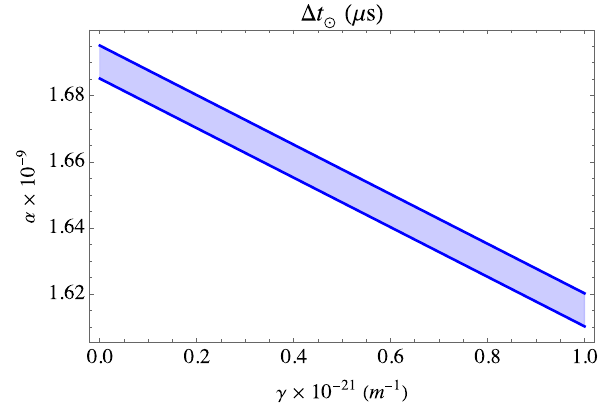
Fig. 4 The constraints of α and γ regarding the time delay in the solar